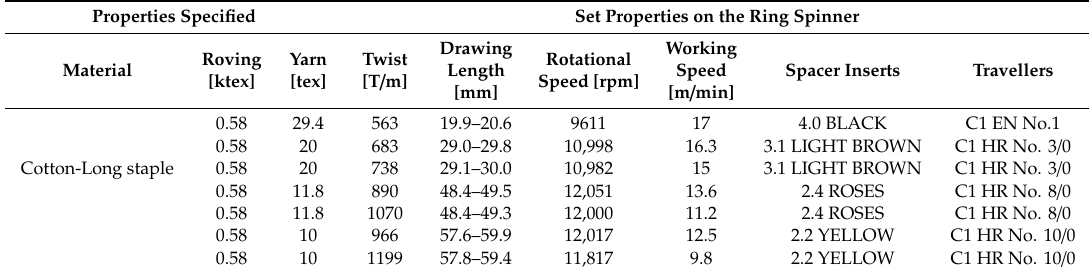
Table 4. Settings on the Laboratory Spinntester.